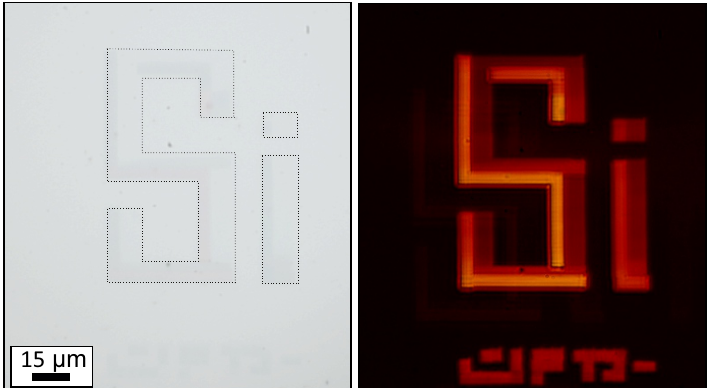
Figure 4. Reflection ( left ) and transmission ( right ) optical images of α -Si film containing laser-annealed microscale poly-Si areas arranged to form “Si” letters. Black dashed lines highlight the location of laser-annealed area in the reflection